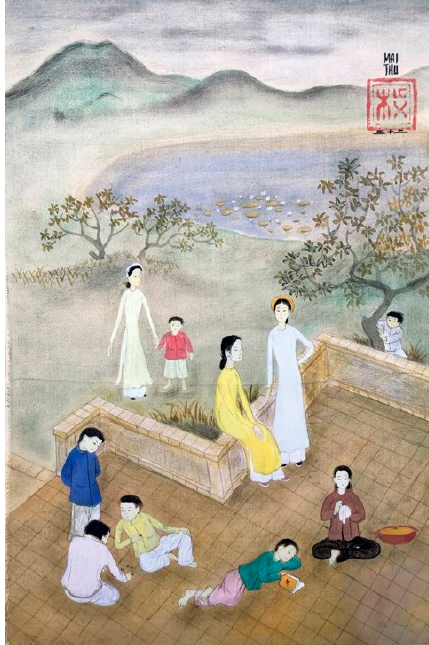
Figure A19. Ra choi —Mai Trung Thu. Auctioned at Auction.fr, May 2016. The image was sourced from The Thao & Van Hoa Newspaper (Vu 2016).